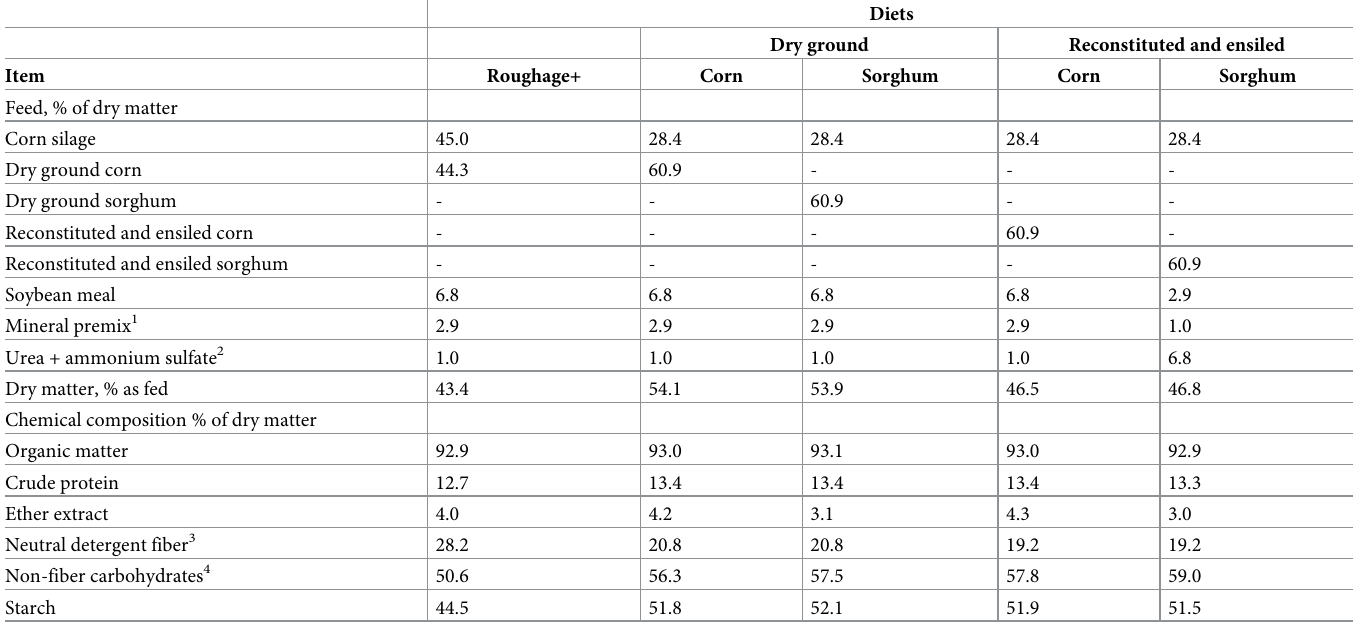
Table 1. Feedstuffs and chemical composition of experimental